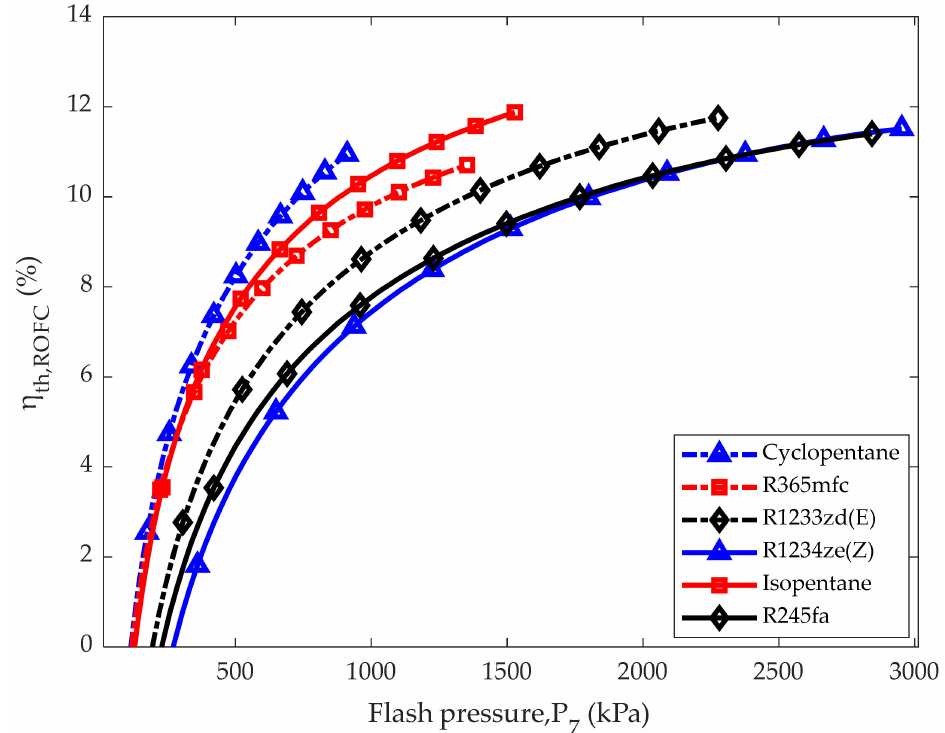
Figure 8. Effect of flash pressure on the thermal